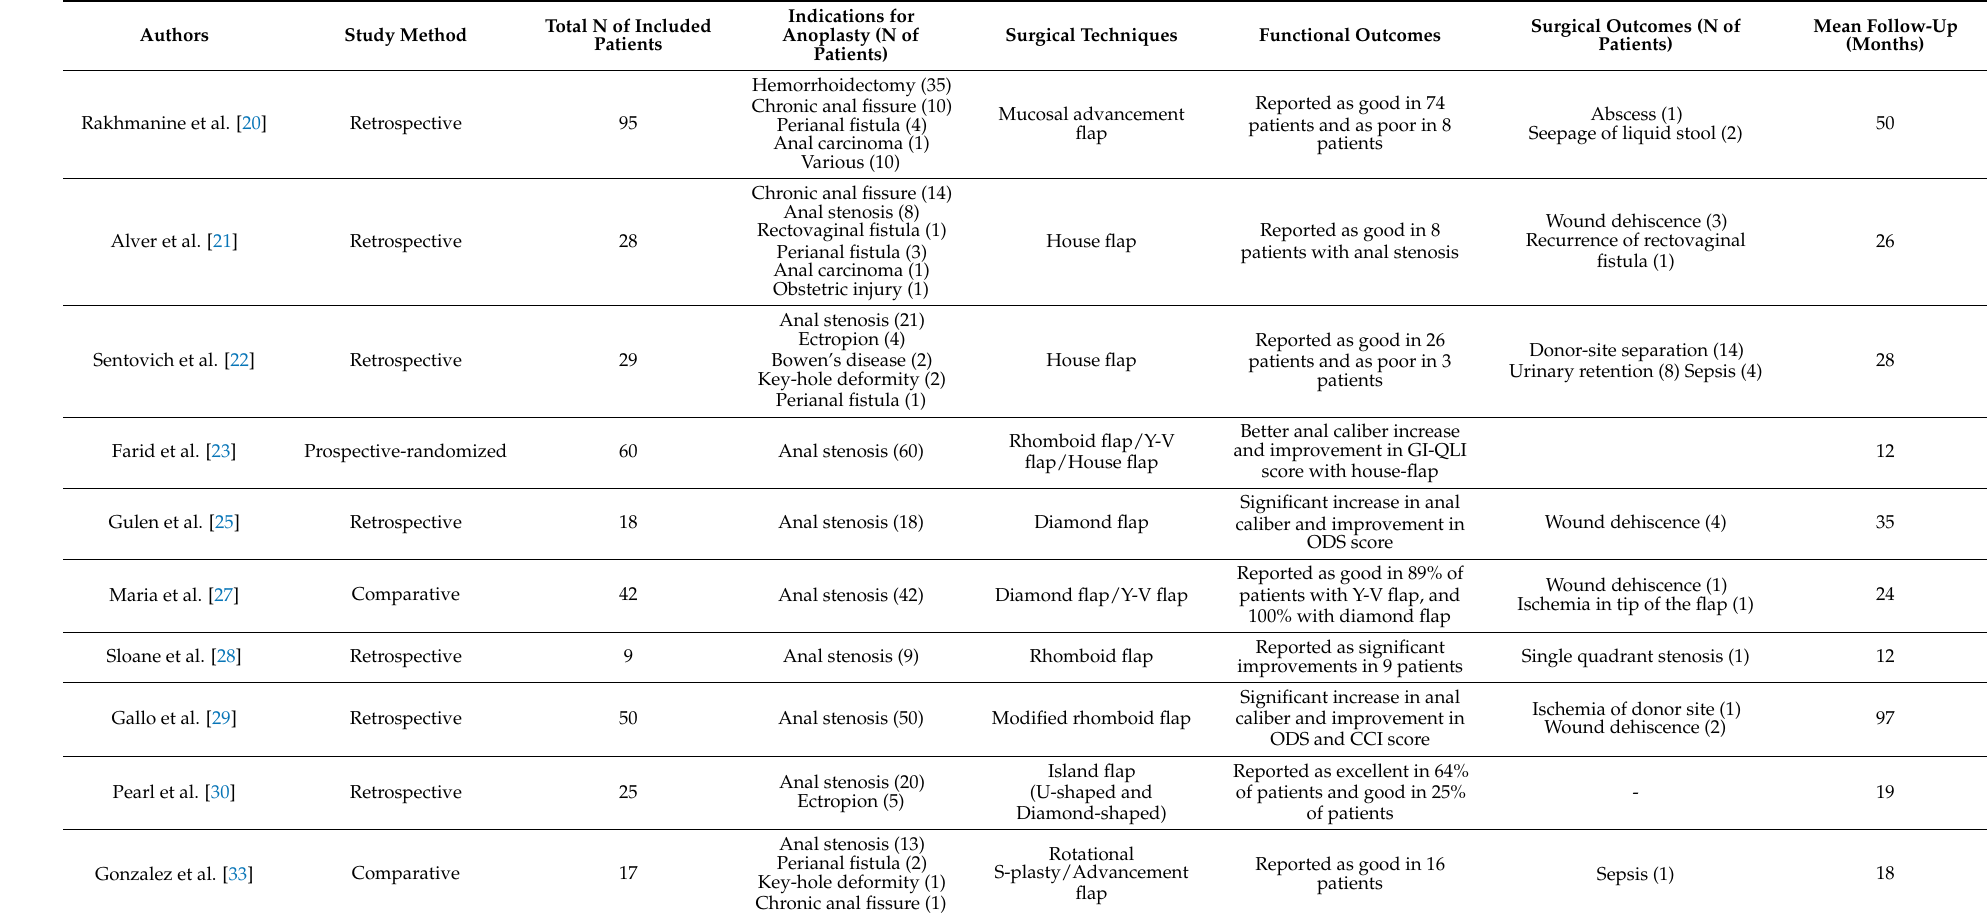
Table 3. Several studies on functional and surgical outcomes after